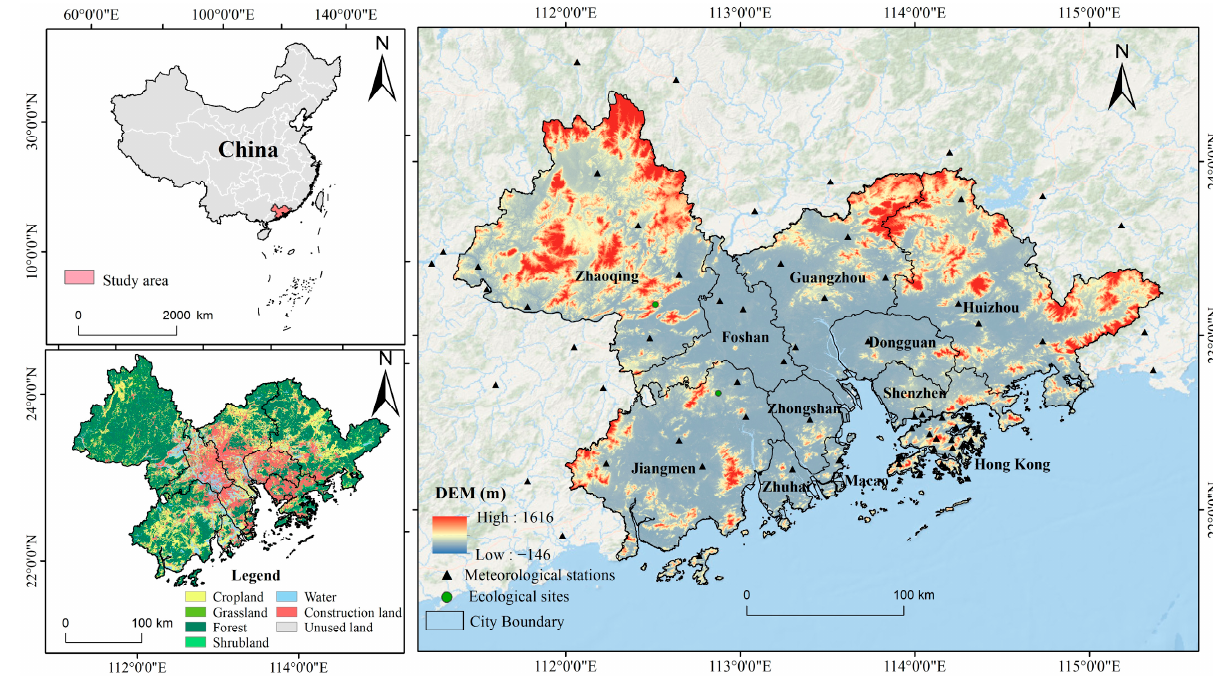
Figure 1. The location of the GBA, with a DEM and land covers in 2020 for the study area.